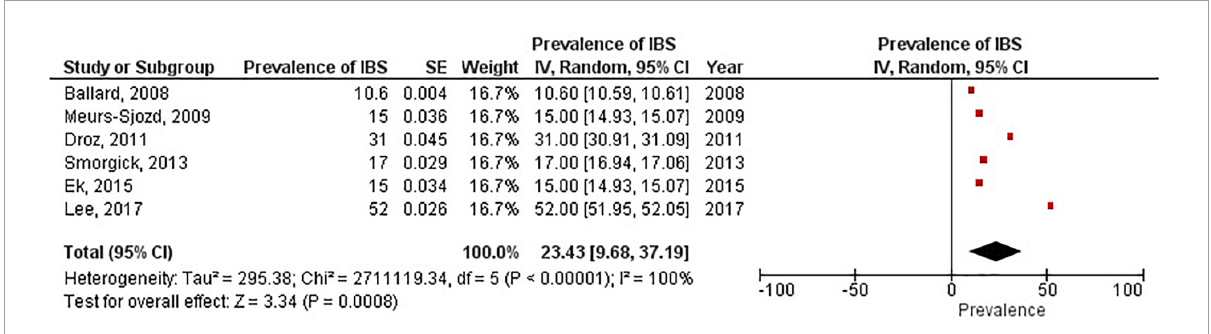
FIGURE5 Forest plot by NOS score.